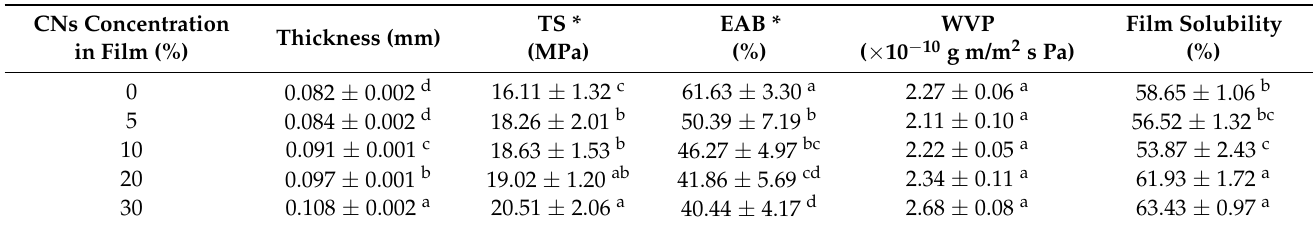
Table 1. Physical and mechanical properties of smart bilayer film incorporated with different concen- trations of cellulose nanosphere